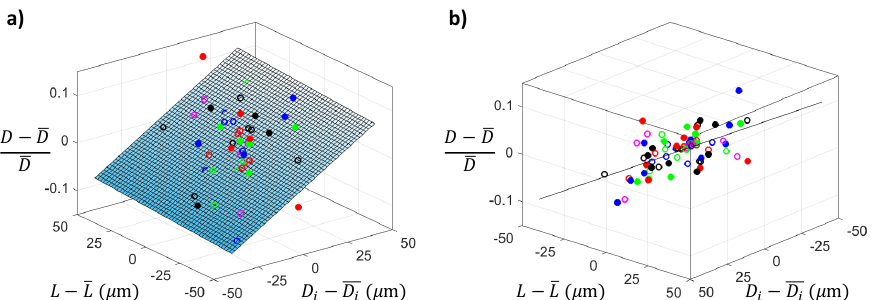
Figure 5. Relative diameter deviation of each nozzle from the mean of the set versus the absolute length and inner diameter deviation of the corresponding original capillary. Symbols correspond to different heating times of the experiments in Table 1 (Capillaries type 1, r = 3.5 mm, z = 15 mm). The plane is the best fit. Graph ( a , b ) represent different view directions.